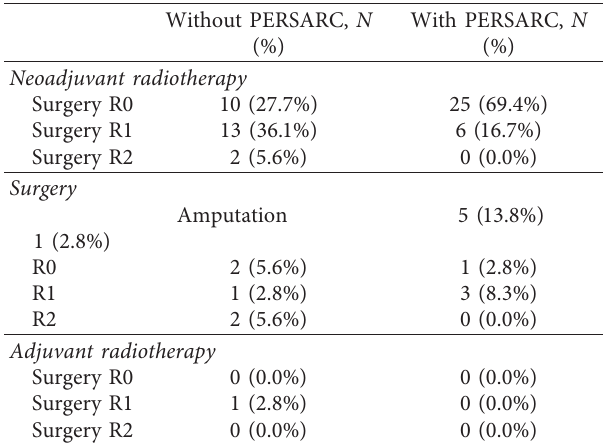
Table 4: Chosen treatment options with and without the use of PERSARC.